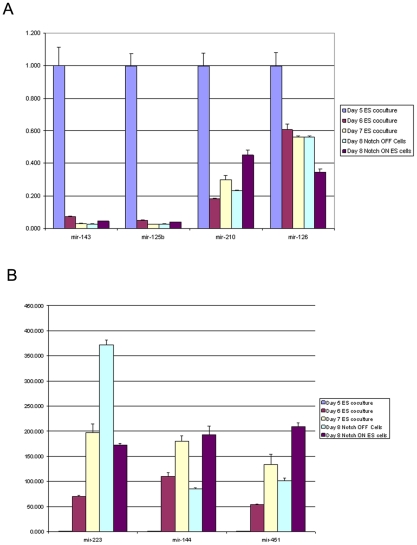
Seven MicroRNA expression on day 5, 6, 7 and 8.Seven mature microRNAs including a) four downregulated and b) three upregulated that whose expression was analyzed using Taqman miRNA expression assay on day 5,6,7 and 8. The expression of the miRNA was normalized against the expression level of the control miRNA snoRNA202 (AF357327) and presented as the mean normalized expression.